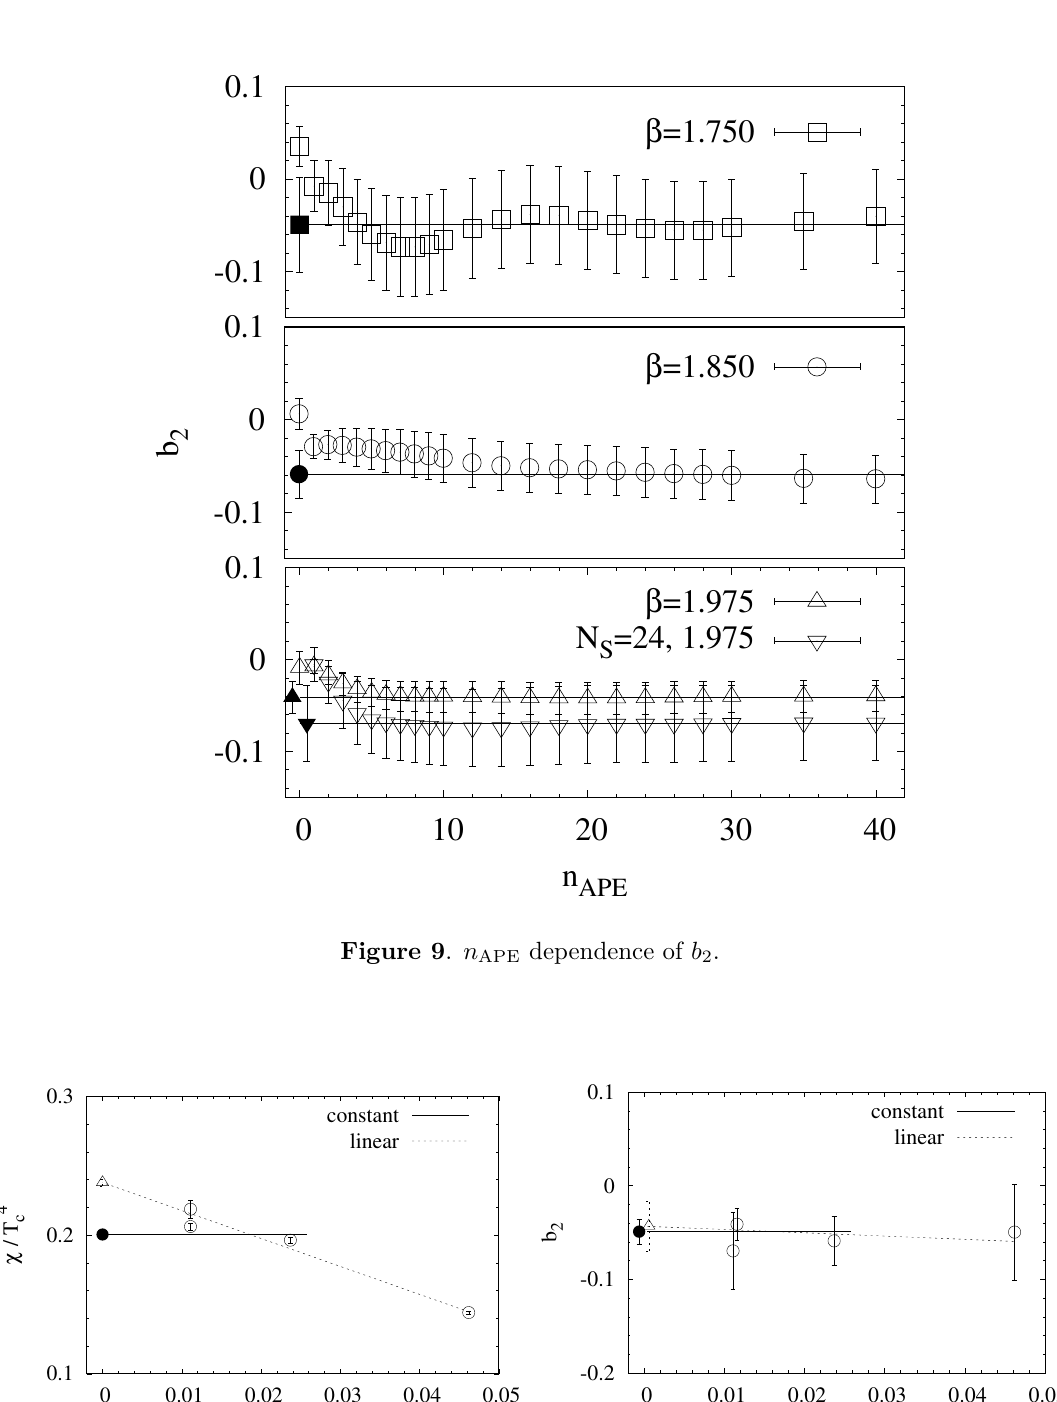
Figure 10 . The continuum limit of χ/T 4 a constant fit using only two finer lattices, and the dashed lines are those from a linear fit using all